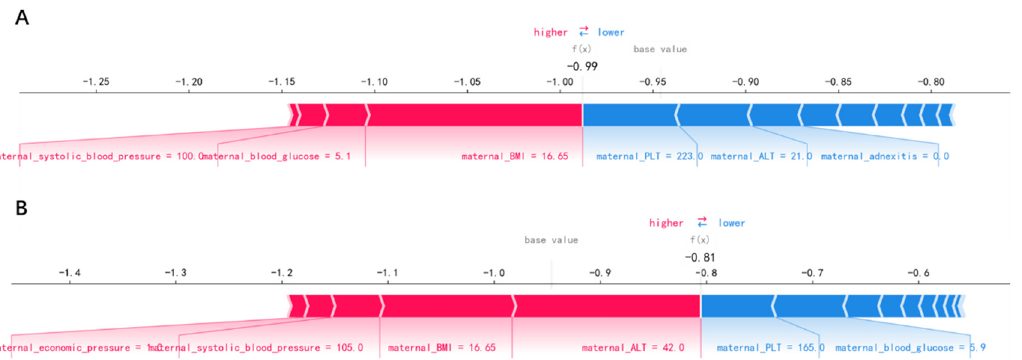
Figure 5. Newborns correctly classified as non-small-for-gestational-age ( A ) and small-for-gestational-age ( B ).